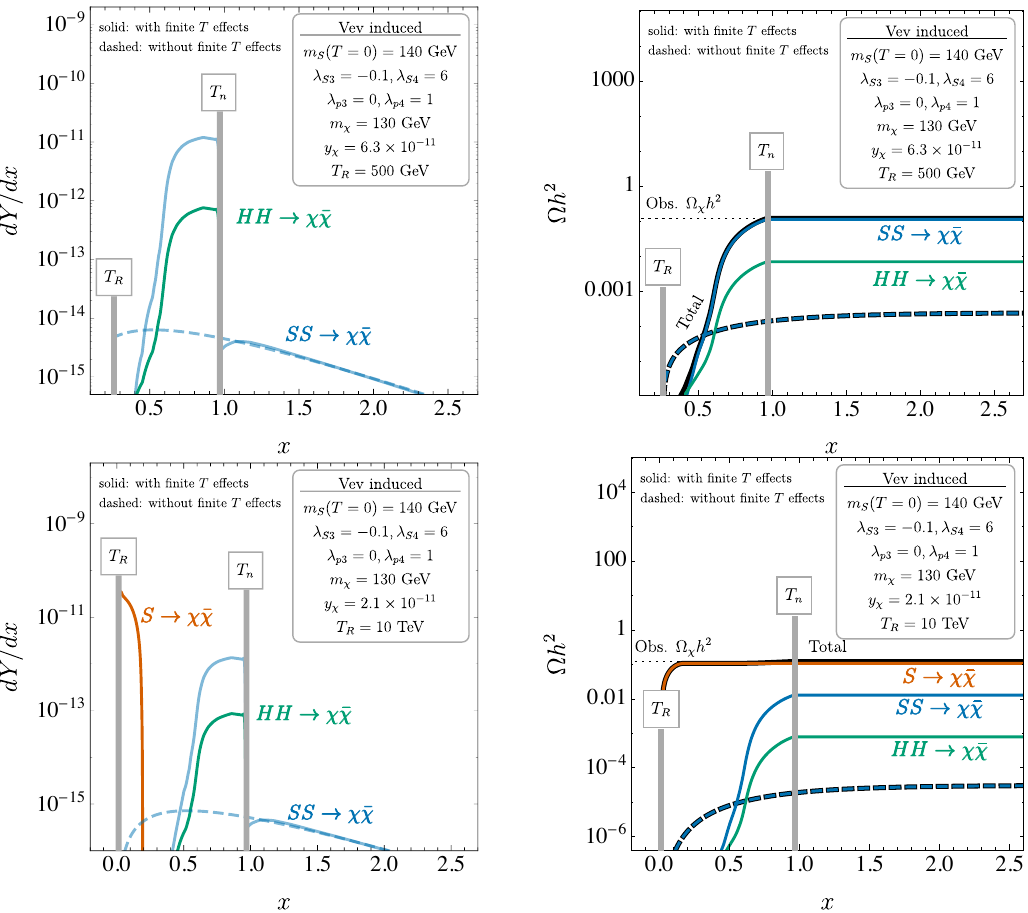
Figure 7 . Evolution of the DM production rate (left) and the DM abundance extrapolated to z = 0 (right) as a function of x (cid:17) m (cid:31) =T for two di(cid:11)erent parameter points in the vev-induced freeze-in scenario de(cid:12)ned by eq. (3.1). Solid curves correspond to the di(cid:11)erent production mechanisms shown in (cid:12)gure 6. The dashed blue line indicates the result one would obtain if thermal corrections and